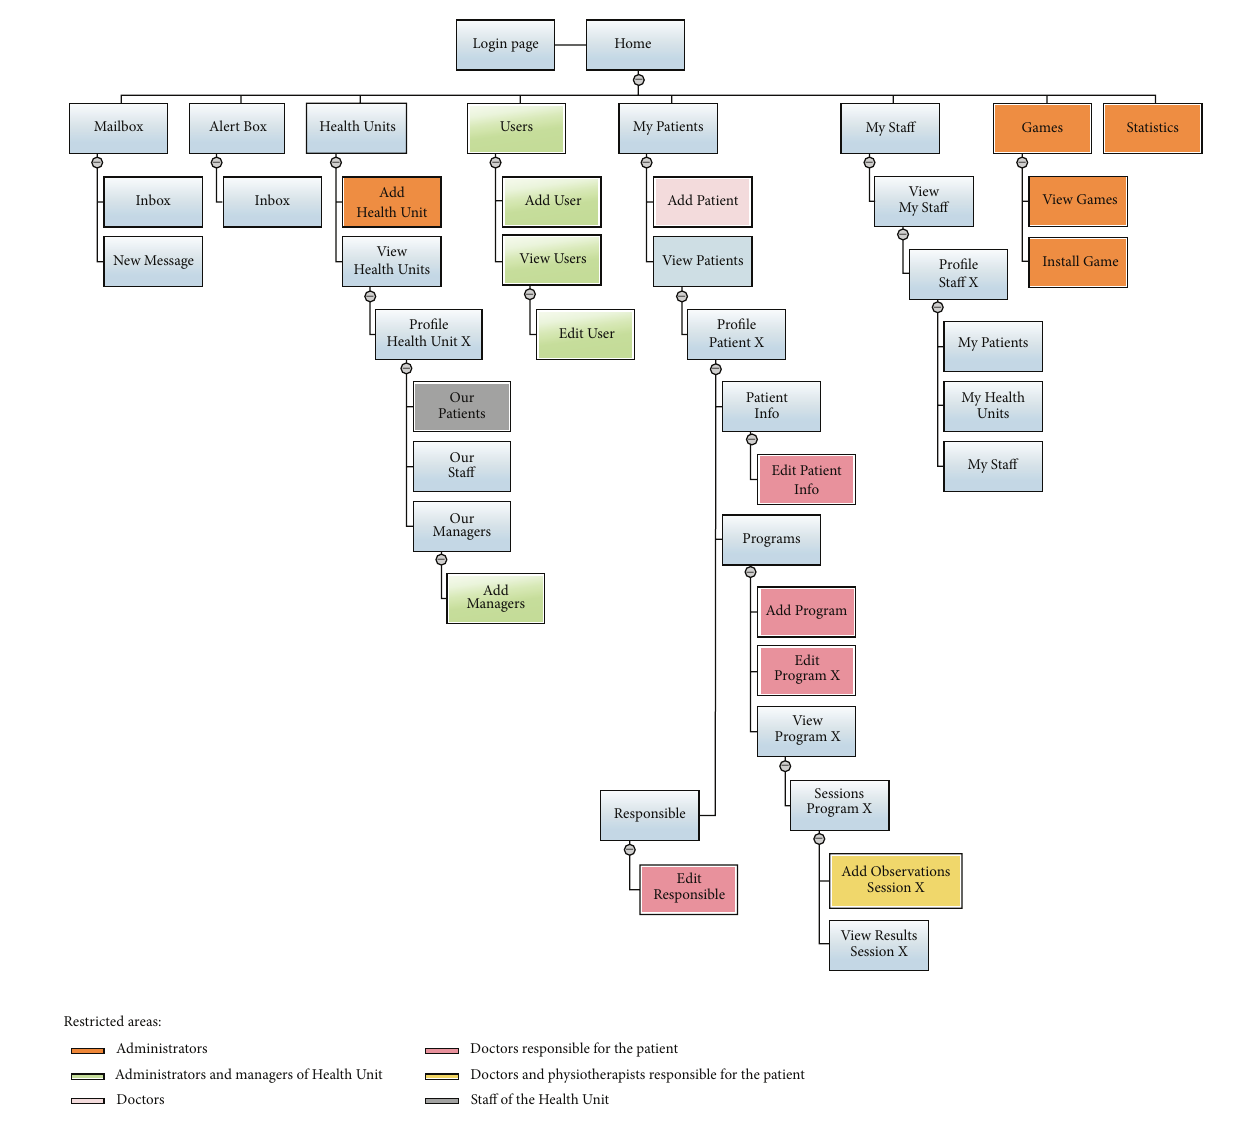
Figure 5: Organogram of the various sections of the Back